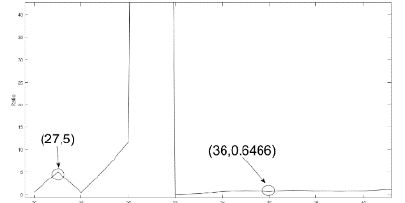
Figure 3. (a) Difference image generated by FDD on Bern. (b) Curve about the ratio value of adjacent GL on Bern difference image. Figure 4 is the local amplification of the Figure 3(b), which shows that the lower and upper thresholds selected are 27 and 36, the values lower than 27 represent the backscatter enhanced regions, those between 27 and 36 are the unchanged regions and higher than 36 represent the backscatter weakened regions.